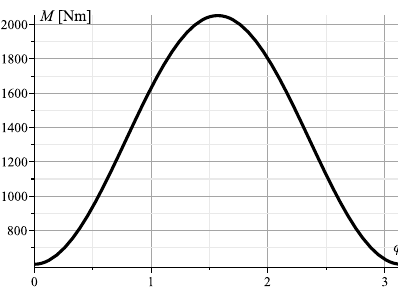
Figure 19: Plot of M ( φ ) (Example 5.2).